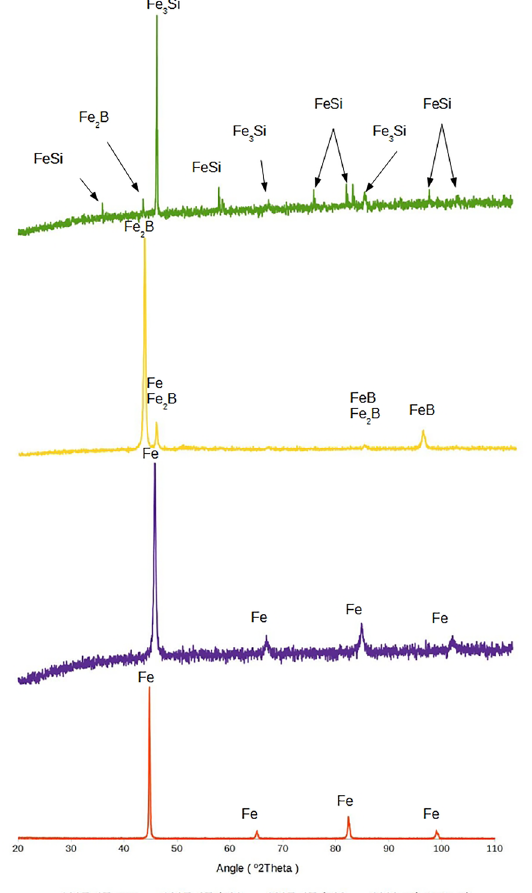
Figure 9. X-ray diffraction patterns for a) 1020 steel substrate without treatment; layer-by-layer of borided AISI 1020 steel treated with Ekabor ® at 1100ºC for 10 h - b) and c) patterns obtained with progressive removal of material, d) borided